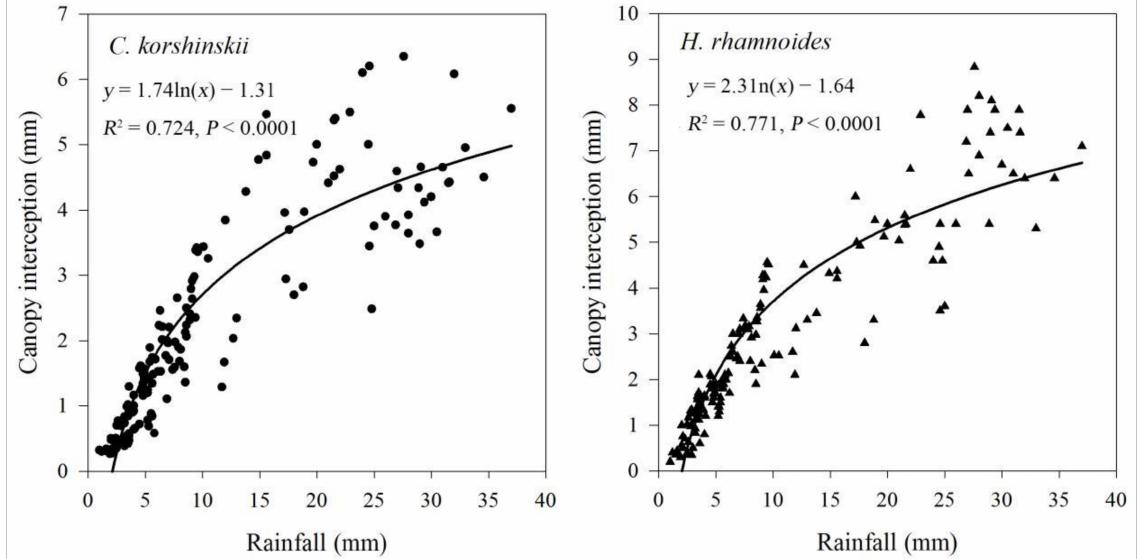
Figure 4. Logistic regression relationship between rainfall and canopy interception for C. korshinskii and H. rhamnoides